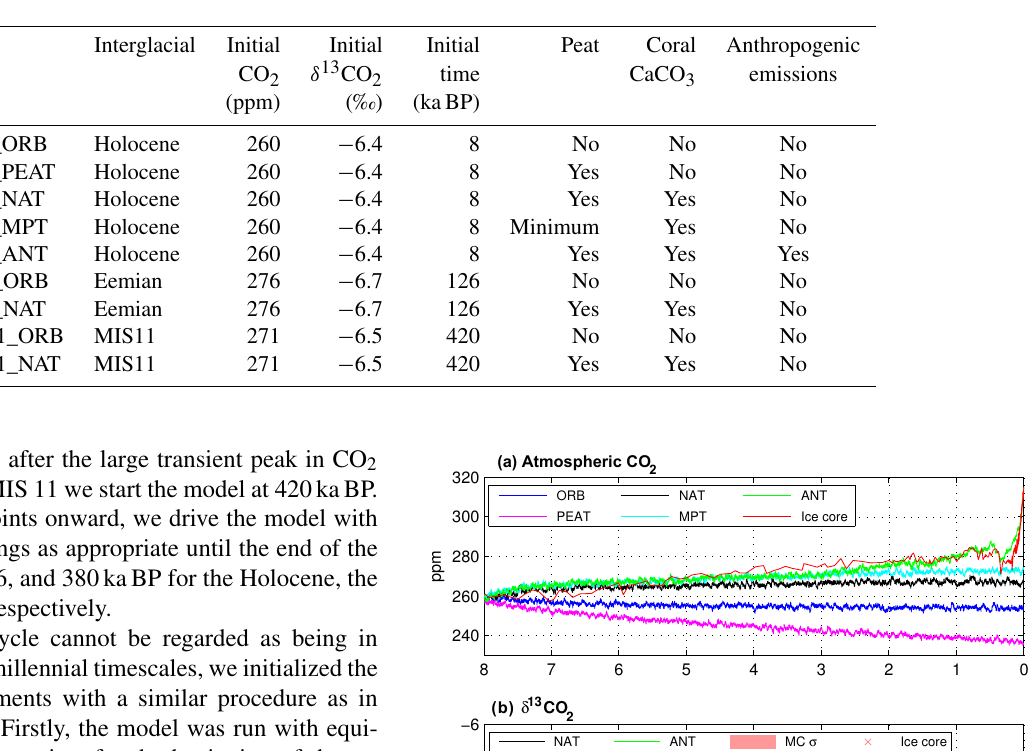
Table 1. Set-up of experiments performed for the interglacials, including the forcing factors varied.